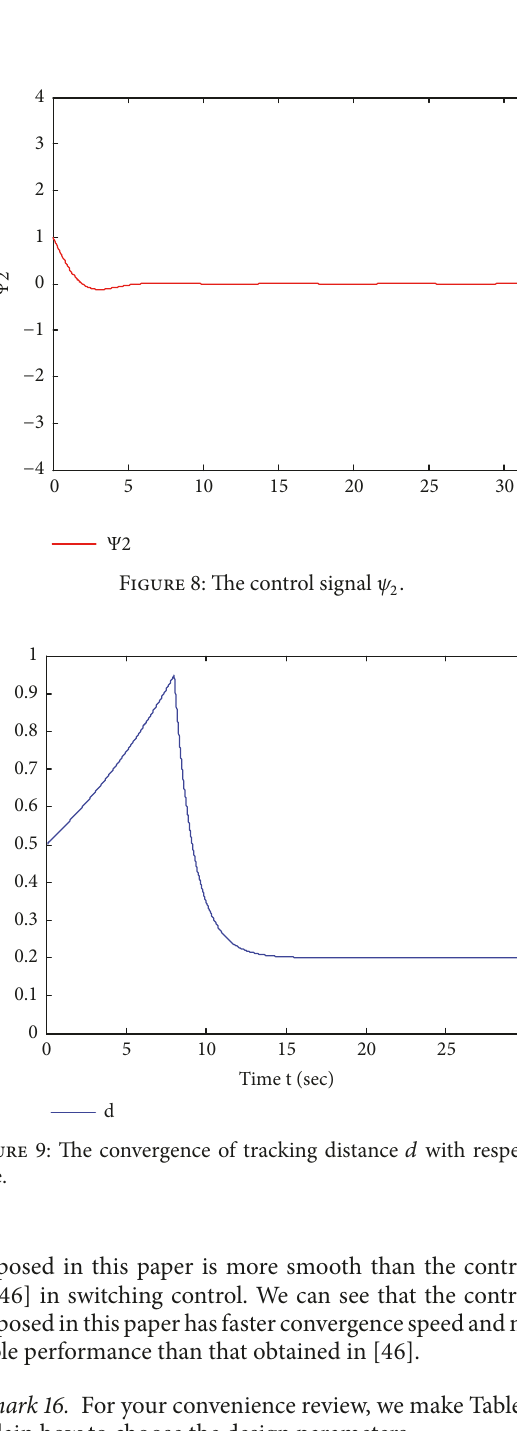
Figure 9: The convergence of tracking distance 𝑑 with respect of time.